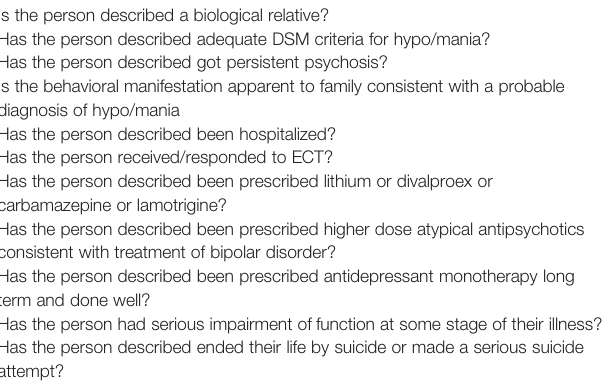
TABLE 3 | Assessment and monitoring of major depression with family history of bipolar disorder or suicide. Careful assessment and follow up of family history Baseline and follow up monitoring of both manic and depressive symptoms Weekly monitoring for 4 weeks Bi-weekly monitoring up to 12 weeks Use of collateral history Speci fi c attention to suicidality including impulsive